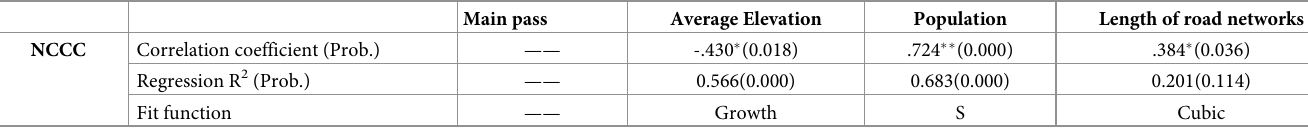
Table 7. The national correlation and regression analysis in the second